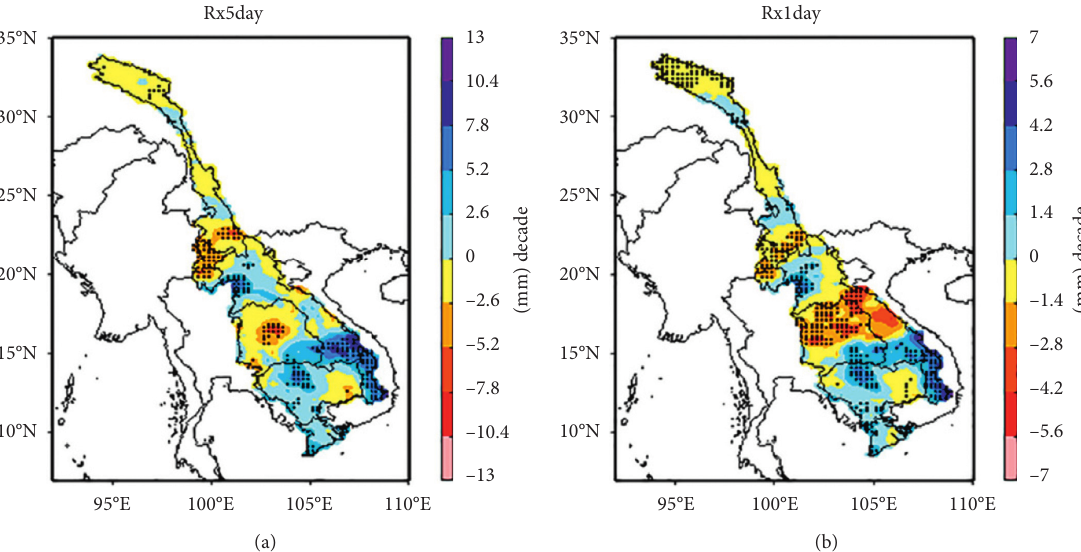
Figure 6: Spatial distribution of trend in Rx5day and Rx1day in the MB over 1951–2015. The black dots indicate that the trend in the grid is significant ( p < 0 . 05) under the Mann-Kendall